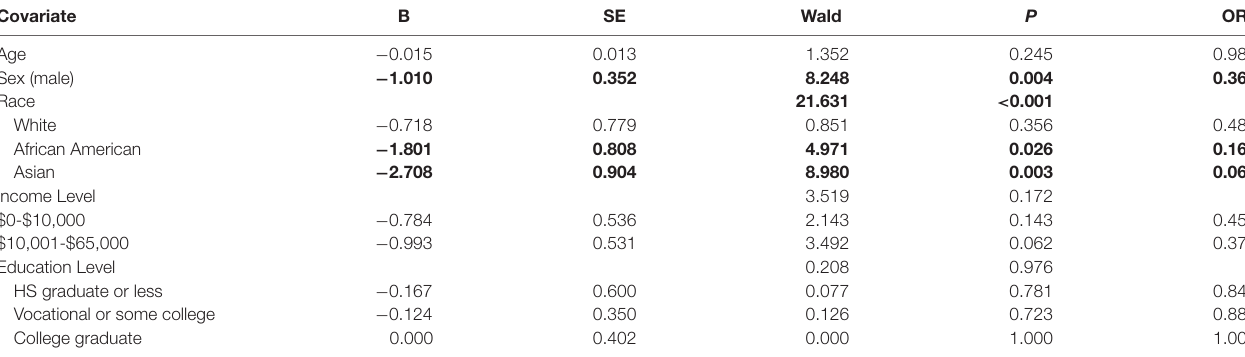
TABLE 2 | Effect of covariates on lifetime DSM-IV diagnosis of any anxiety disorder. Covariate B SE Wald P OR Age − 0.015 0.013 1.352